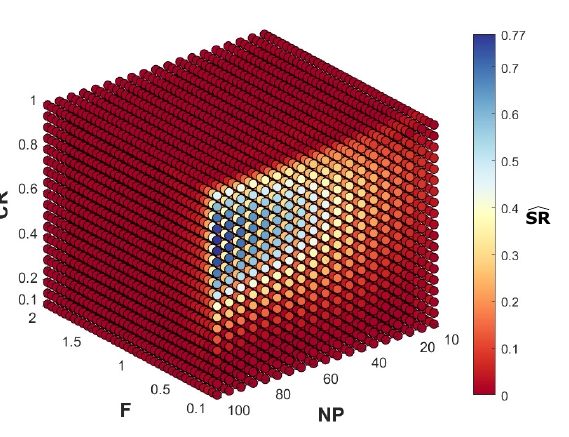
Figure 6. The illustration of 14,709 parameter combinations of Fcn3. Each point reflects a combination of NP, F and CR. The point color depends on (cid:99) SR precision value. The dark blue color means a high DE precision to achieve the requirements. The dark red color means a small DE precision to achieve the